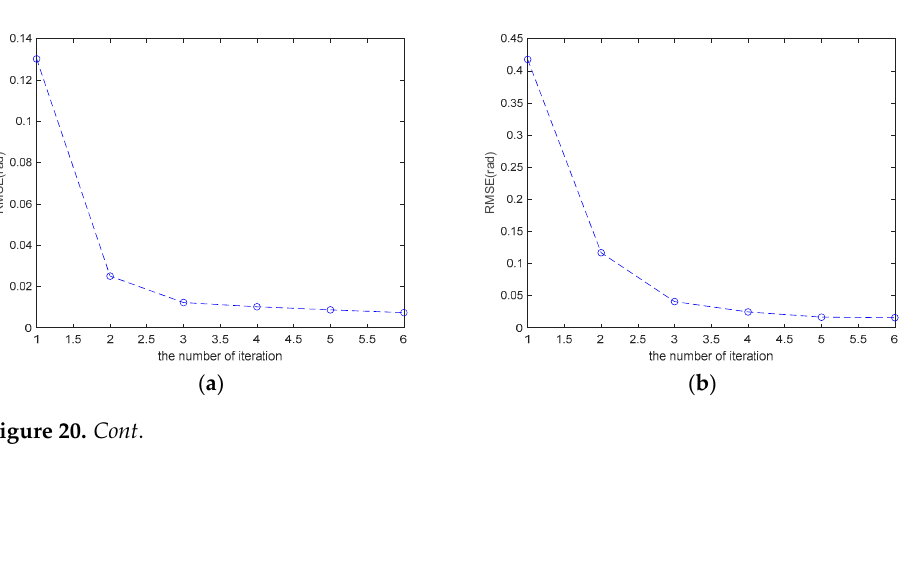
Figure 19. Azimuth profile of targets in the red dashed boxes in Figure 18. ( a ) Without compensation and ( b ) with compensation.